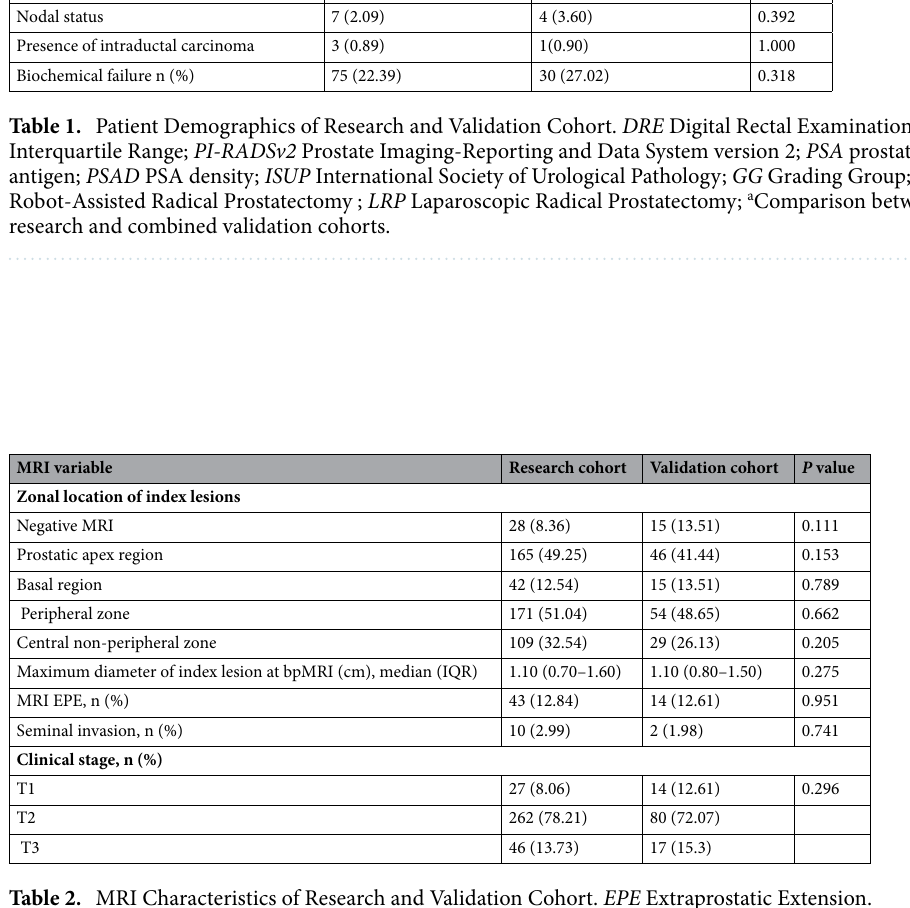
Table 2. MRI Characteristics of Research and Validation Cohort. EPE Extraprostatic